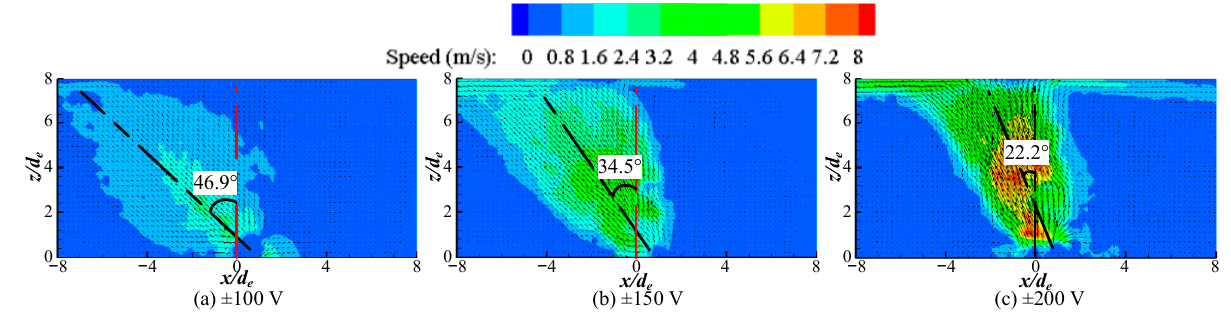
Figure 8. Velocity vector maps, contours and vectoring angles at different driving voltages.